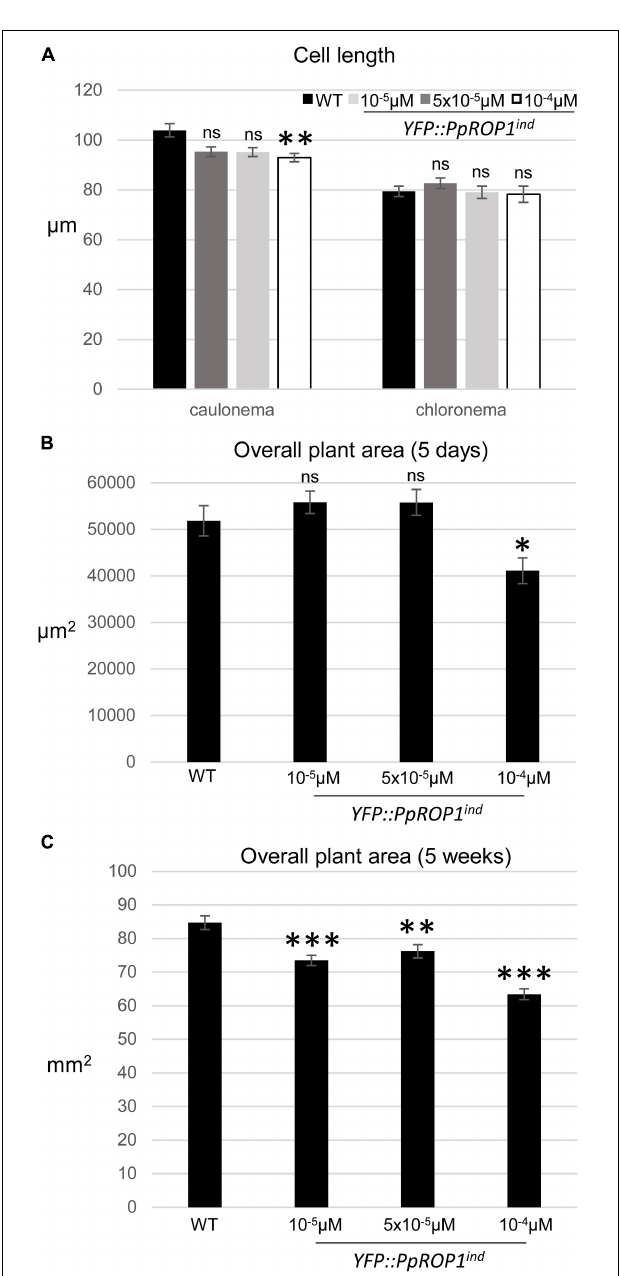
FIGURE 10 | Quantitative comparison of the growth of WT plants and of YFP::PpROP1 ind plants induced with 10 − 5 µ M, 5 × 10 − 5 µ M, or 10 − 4 µ M estradiol. (A) Length of fully expanded first subapical cells of 5-day-old protonemata. (B) Total area of 5-day-old protonemata. (C) Total area of 5-week-old plants. The statistical significance of differences between WT and other data sets was assessed using ANOVA (Bonferroni-Holm, one factor). ∗ P < 0.05; ∗∗ P < 0.01; ∗∗∗ P < 0.001; ns: not significantly different. Error bars: standard error of the mean.